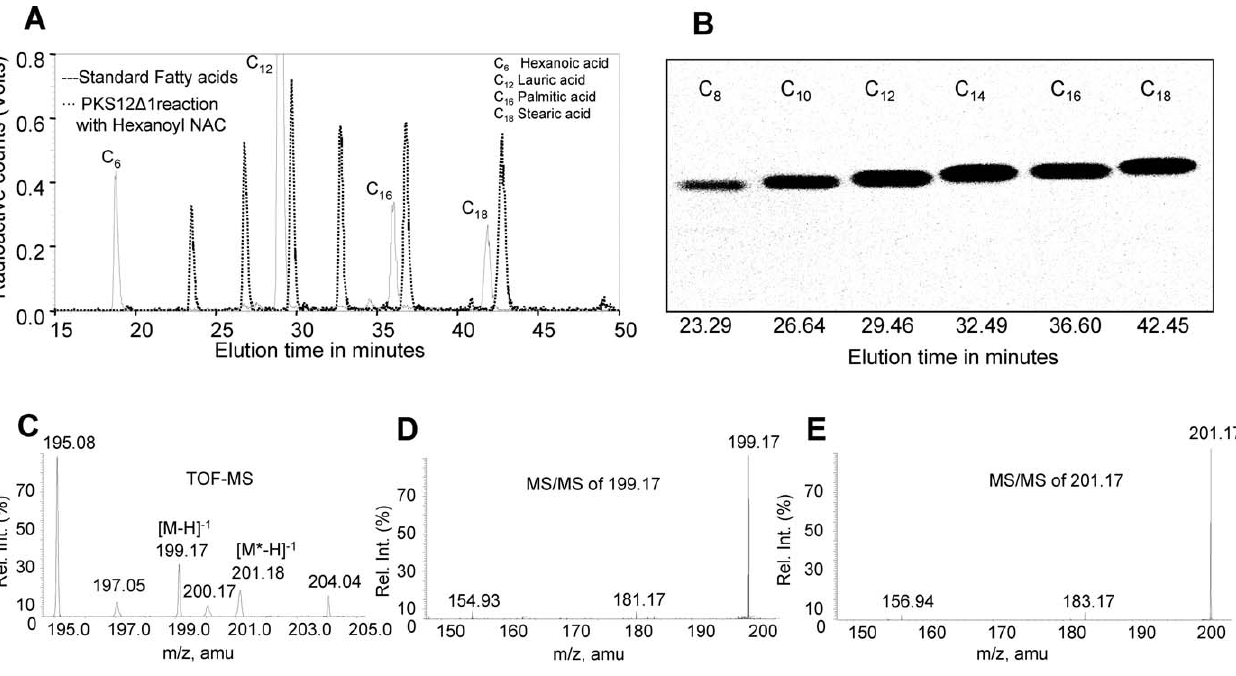
Figure 4. Radio-HPLC and Mass Spectrometry Characterization of PKS12 D 1 Products (A) Characterization of products on HPLC. The radioactive product synthesized by PKS12 D 1 was analyzed on reverse-phase HPLC, and the elution times were determined by a radioactive detector. The reaction was primed with a hexanoyl starter that undergoes two carbon extensions with MCoA. The product peaks superimpose with radioactive standards. The traces are stacked with an x -axis offset for clarity. (B) Autoradiograph of the HPLC-resolved PKS12 D 1 products that were concentrated and analyzed by radio-TLC. The R f of various bands is C 8 (0.468), C 10 (0.476), C 12 (0.492), C 14 (0.507), C 16 (0.523), and C 18 (0.539). (C) ESI-MS analysis of the 29.46-min HPLC peak. Molecular ion peak of 199.17 confirms the eluent to be lauric acid. Isotopic distribution is in concordance with radioactive substrates utilized in the assay. (D) Tandem MS of [M-H] (cid:2) 1 199.17 peak. The fragmentation pattern was similar to standard lauric acid corresponding to decarboxylation (154.93) and loss of water (181.17) from the parent ion. (E) Tandem MS of the [M * -H] (cid:2) 1 14 C peak of lauric acid 201.17 peak. The characteristic peaks show mass difference of 2, corresponding to 14 C